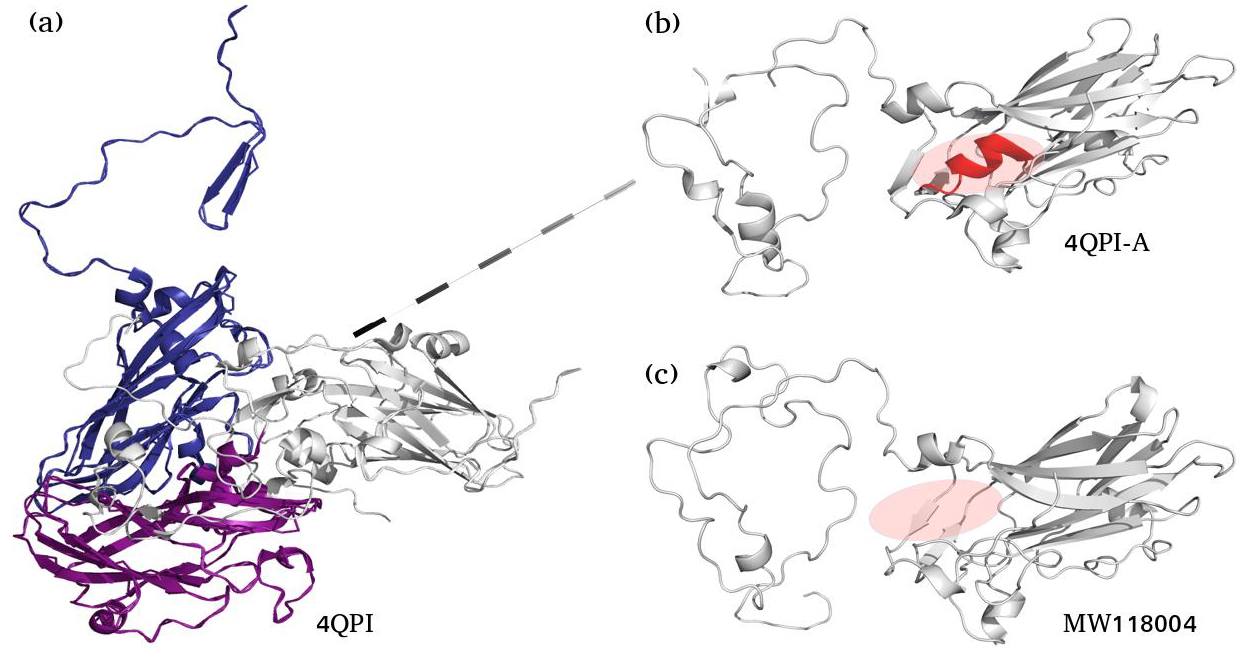
Figure 5. Effect of the deleted region found in the Tunisian variant on the three-dimensional structure of HAV-VP1 protein. ( a ) HAV capsid protein (PDB-ID: 4QPI). Gray protein corresponds to VP1, blue to VP2 and purple to VP3. ( b ) Top view Figure 1 protein (PDB-ID: 4QPI-A). ( c ) The three-dimensional predicted structure of the VP1 protein of the Tunisian variant isolated in 2018 (accession number: MW118004). The homology model was obtained using modeler and as a template HAV-VP1 protein (PDB: 4QPI-A). Circled region indicates the destroyed helix (colored in red) resulted from the deletion of 6 amino acids in the VP1 protein